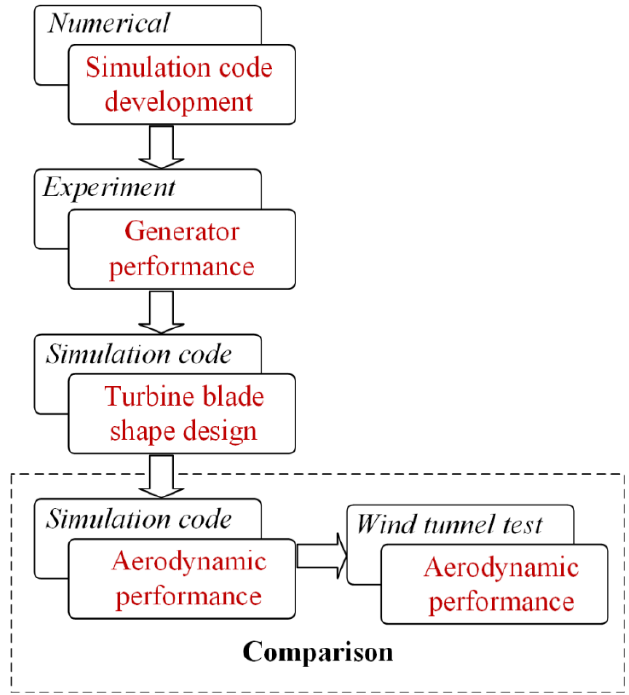
Figure 1. Flowchart for designing the HAWT turbine